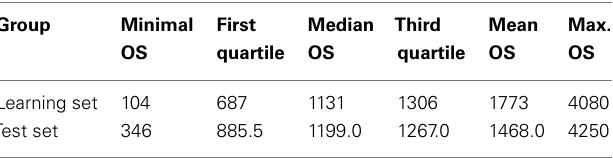
Table 6 | Characteristics of the two groups of patients according to OS statistics